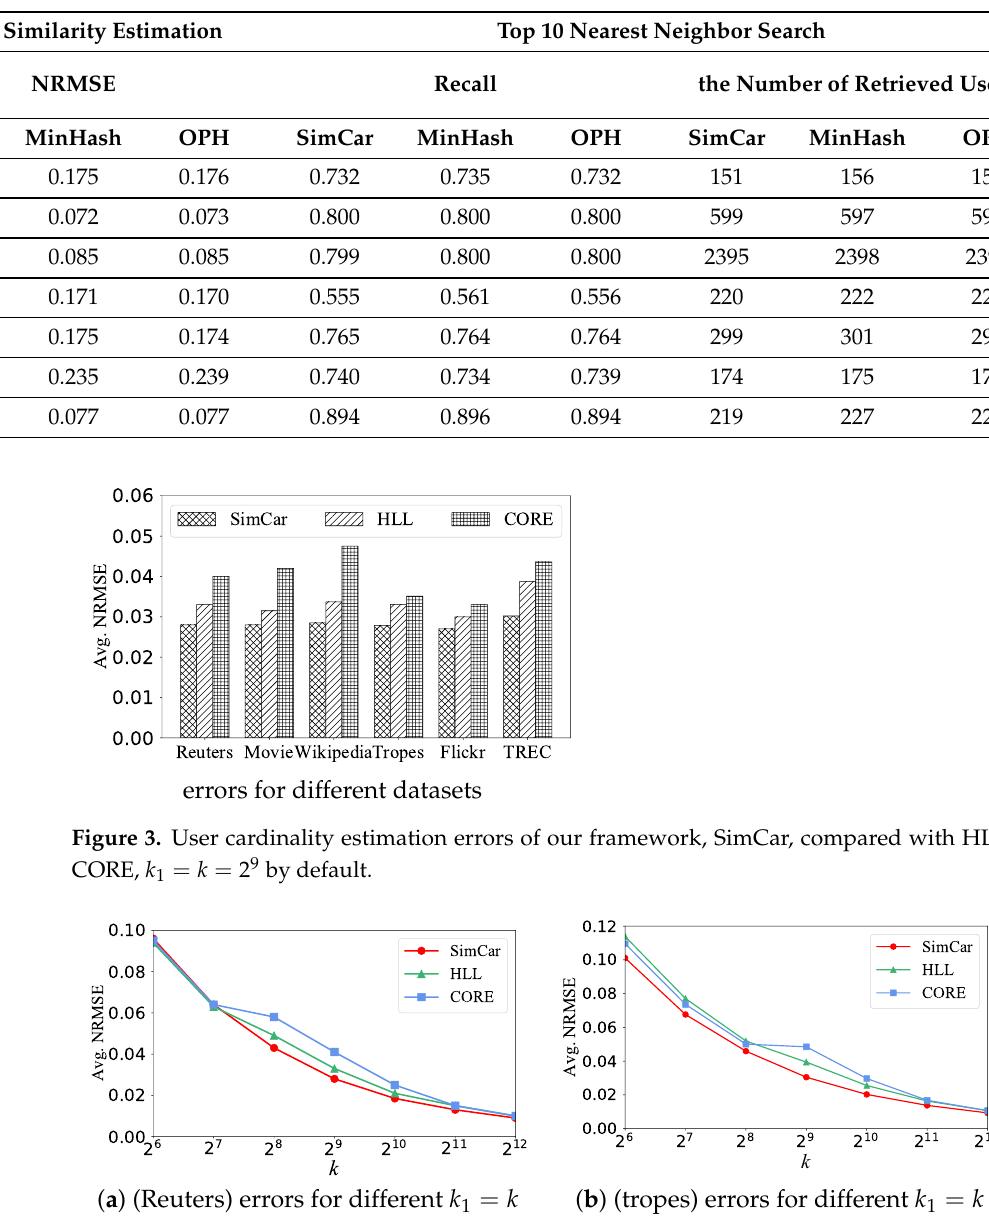
Table 3. Performance of our framework, SimCar, compared with MinHash and OPH for Jaccard similarity estimation and nearest neighbor search with k = 2 9 , c = 2.